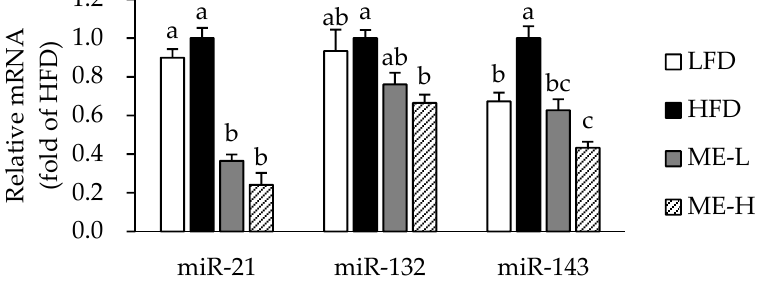
Figure 4. Effect of mulberry fruit extract on microRNA expression in white adipose tissue. The levels were normalized relative to the RNU6B. Values are expressed as mean ± SEM (n = 8/group). Bars with different letters indicate a significant difference at p < 0.05. Abbreviations: LFD, low-fat diet; HFD, high-fat diet; ME-L, HFD + 5 g/kg diet of mulberry fruit extract; ME-H, HFD + 10 g/kg diet of mulberry fruit extract; and miR, microRNA.